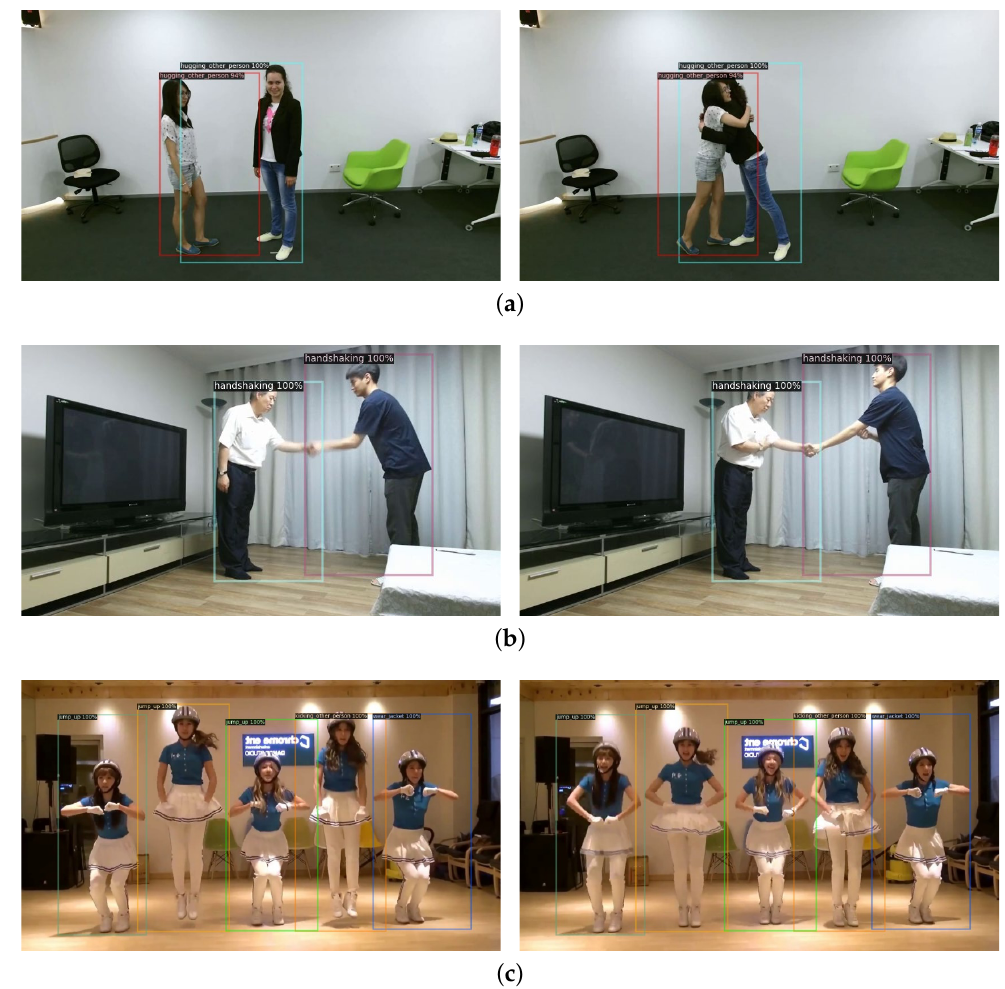
Figure 6. Recognized actions of the proposed human instance-level video action recognition frame- work. ( a ) Output frames of hugging another person on the NTU RGB + D dataset. ( b ) Output frames of handshaking on the unseen ETRI-Activity3D dataset [44,45]. ( c ) Output frames targeted by Jump up of in-the-wild dance